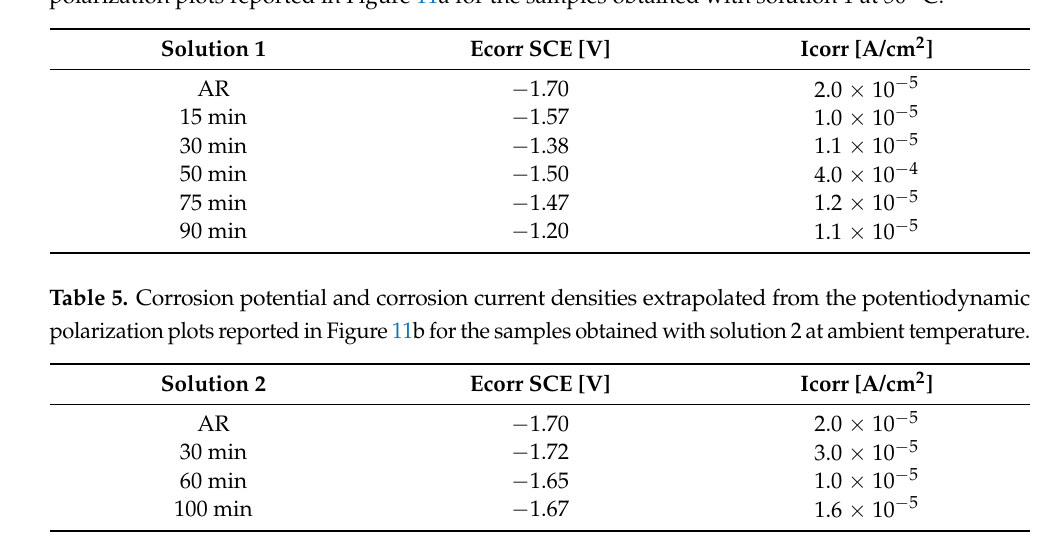
Table 4. Corrosion potential and corrosion current densities extrapolated from the potentiodynamic polarization plots reported in Figure 11a for the samples obtained with solution 1 at 50 ◦ C.